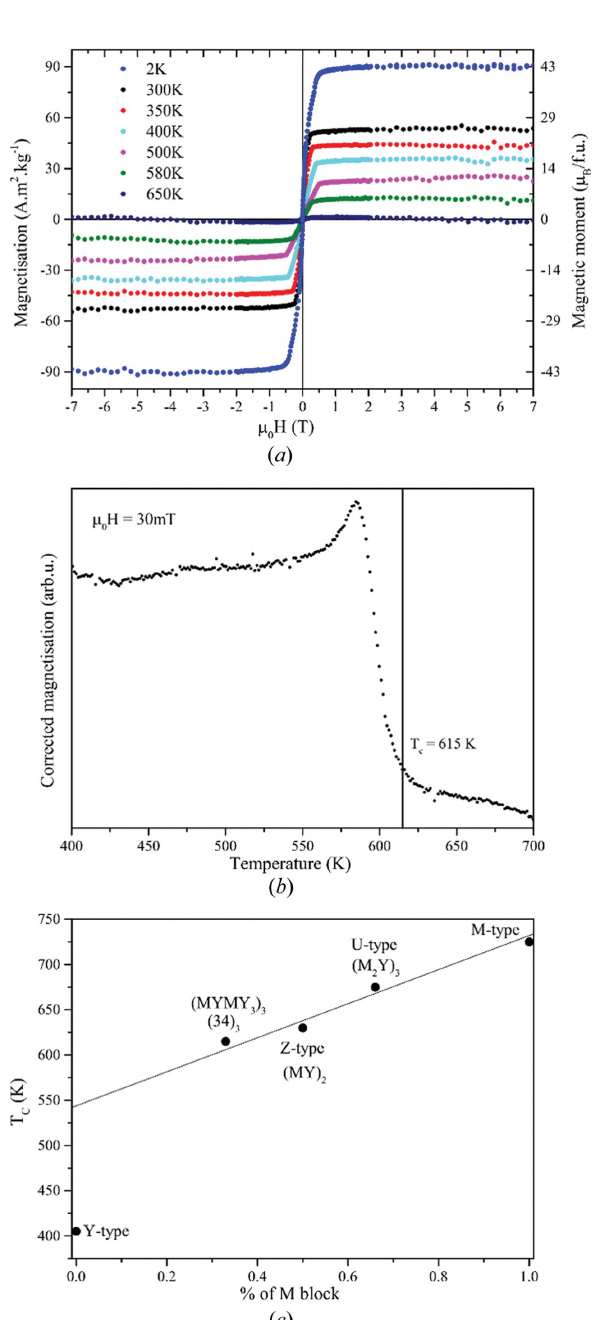
Figure 17 ( a ) Isothermal magnetization as a function of applied magnetic field of the (34) 3 hexaferrite at selected temperatures. ( b ) Magnetization as a functions of temperature between 400 and 700 K under an external magnetic field of 30 mT. The Curie temperature is highlighted with a vertical line at T C = 615 K. ( c ) Curie temperatures of the M-type, Y-type and mixed-layer hexaferrites as a function of the percentage of M block present within their stacking